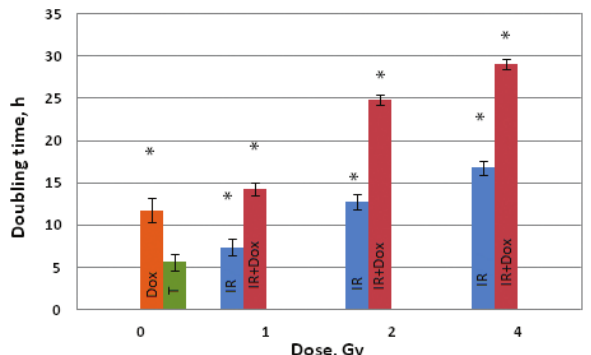
Figure 3. HeLa doubling time as a function of irradiation dose (* – reliable difference with the statistical significance level at р < 0.05; diagram errors – standard error of the mean; IR – ioniz - ing radiation; Dox – doxorubicin; T –